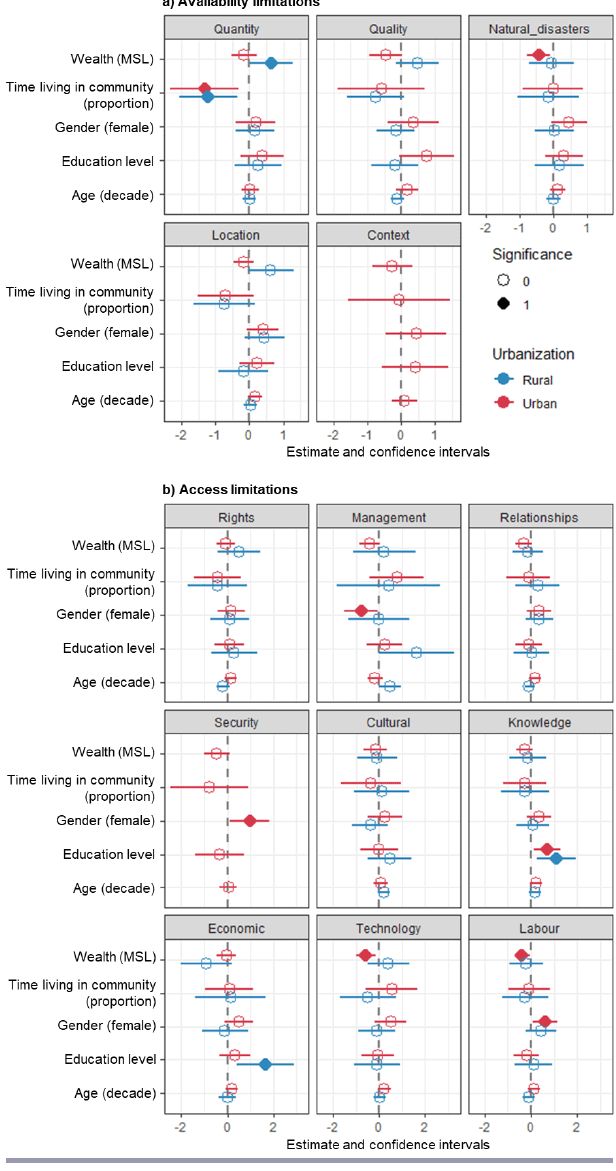
Fig. 5 . Relationship between socio-demographic characteristics and the number of perceived limitations to ecosystems services relating to (a) availability and (b) access in urban and rural areas. Ecosystem service types were controlled for in the model, but are omitted from the graph. Urban and rural analyses were performed separately for each limitation, but are illustrated in the same